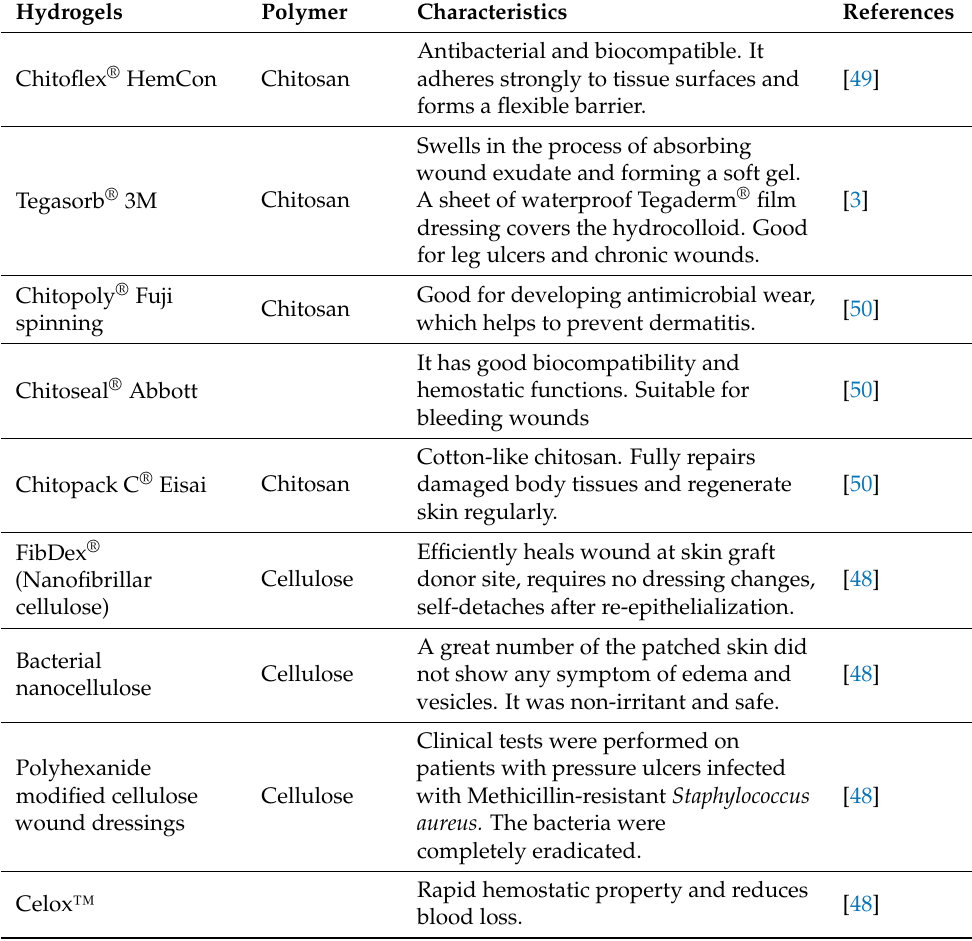
Table 2. Some chitosan and cellulose-based hydrogels in clinical trials/marketed product.